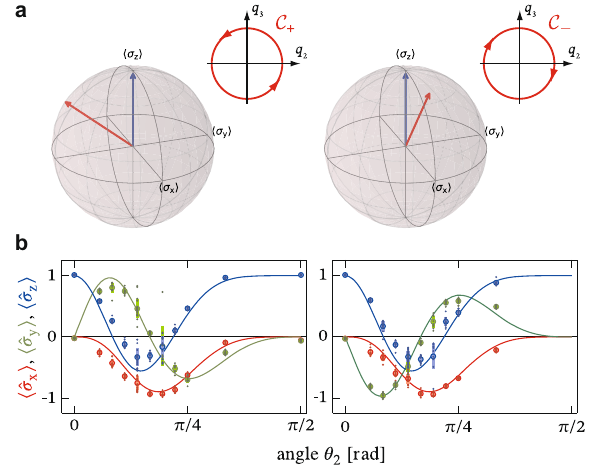
Fig. 2 Acquisition of W.-Z. phase within the DS. a Bloch vector within the DS before (blue arrows) and after (red arrows) adiabatically following paths C ± , which traced the same loop with opposite direction (inset). The initial Bloch vector was h ^ σ i ¼ ð 0 ; 0 ; 1 Þ and the path-dependent fi nal Bloch vectors were h ^ σ þ i ¼ ð(cid:3) 0 : 62 ð 3 Þ ; (cid:3) 0 : 70 ð 5 Þ ; 0 : 47 ð 2 ÞÞ and h ^ σ (cid:3) i ¼ ð(cid:3) 0 : 68 ð 1 Þ ; 0 : 59 ð 5 Þ ; 0 : 40 ð 5 ÞÞ . The laboratory parameters are Ω A = Ω B = h × 1.4 kHz. b The angle dependence of the fi nal Bloch vectors for paths with forward ramp (left) and reverse ramp (right). The dots are individual data and the solid curves are the theory. The error bars show the standard deviation of the